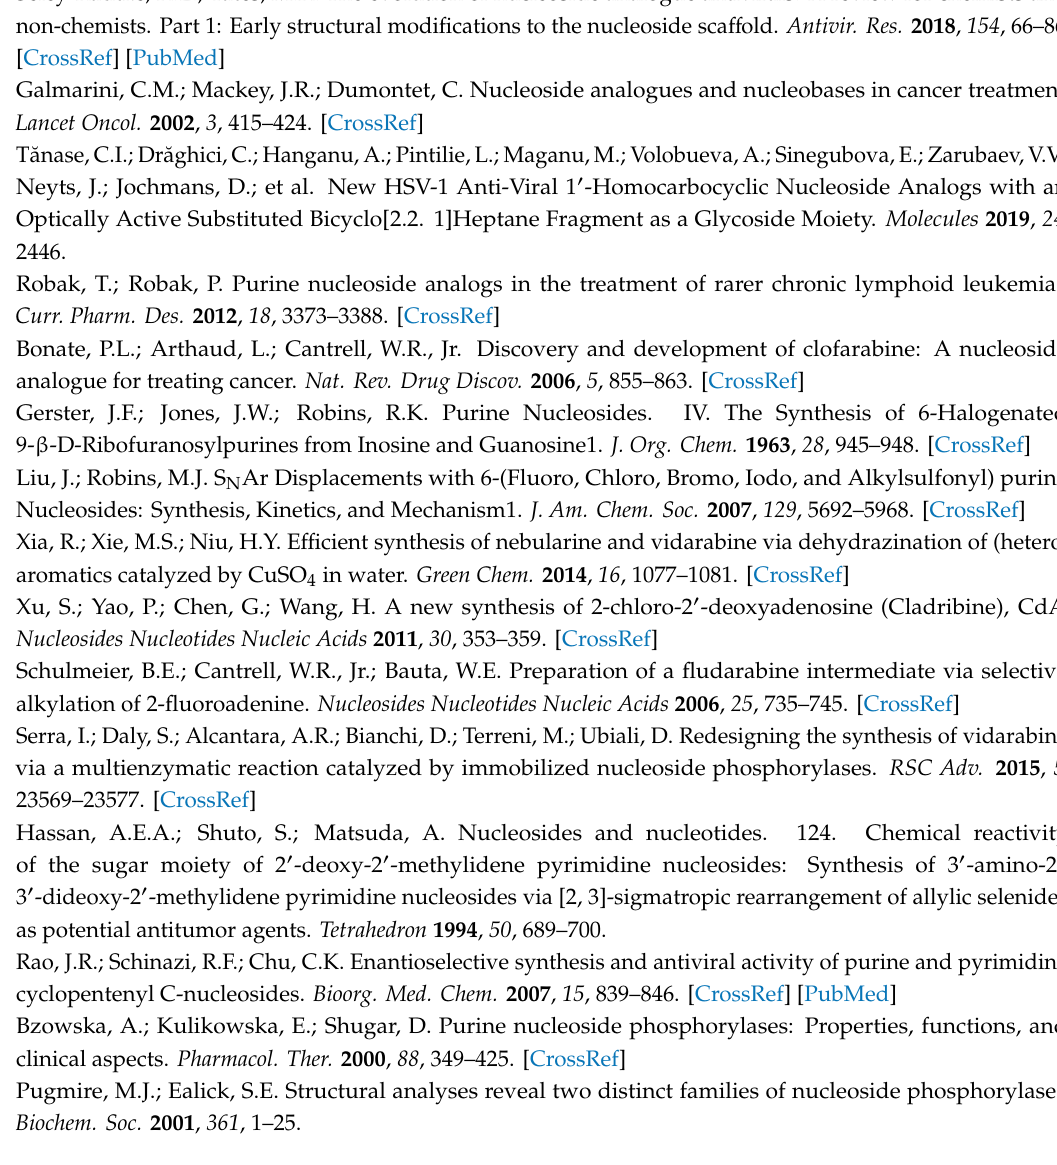
Supplementary Materials: The following are available online, Figure S1: E ff ect of proportion of glycosyl donor and purine base on the biosynthesis of 2-amino-6-chloropurine ribonucleoside, Figures S2–S20: HPLC dates of synthesis of various purine nucleoside analogs, Figure S21: 1H-NMR spectrum of 2-amino-6-chloropurine nucleoside, Figure S22: 13C-NMR spectrum of 2-amino-6-chloropurine nucleoside, Table S1: Identities of the reported PNPs, Table S2: Half-life of Am PNP at di ff erent